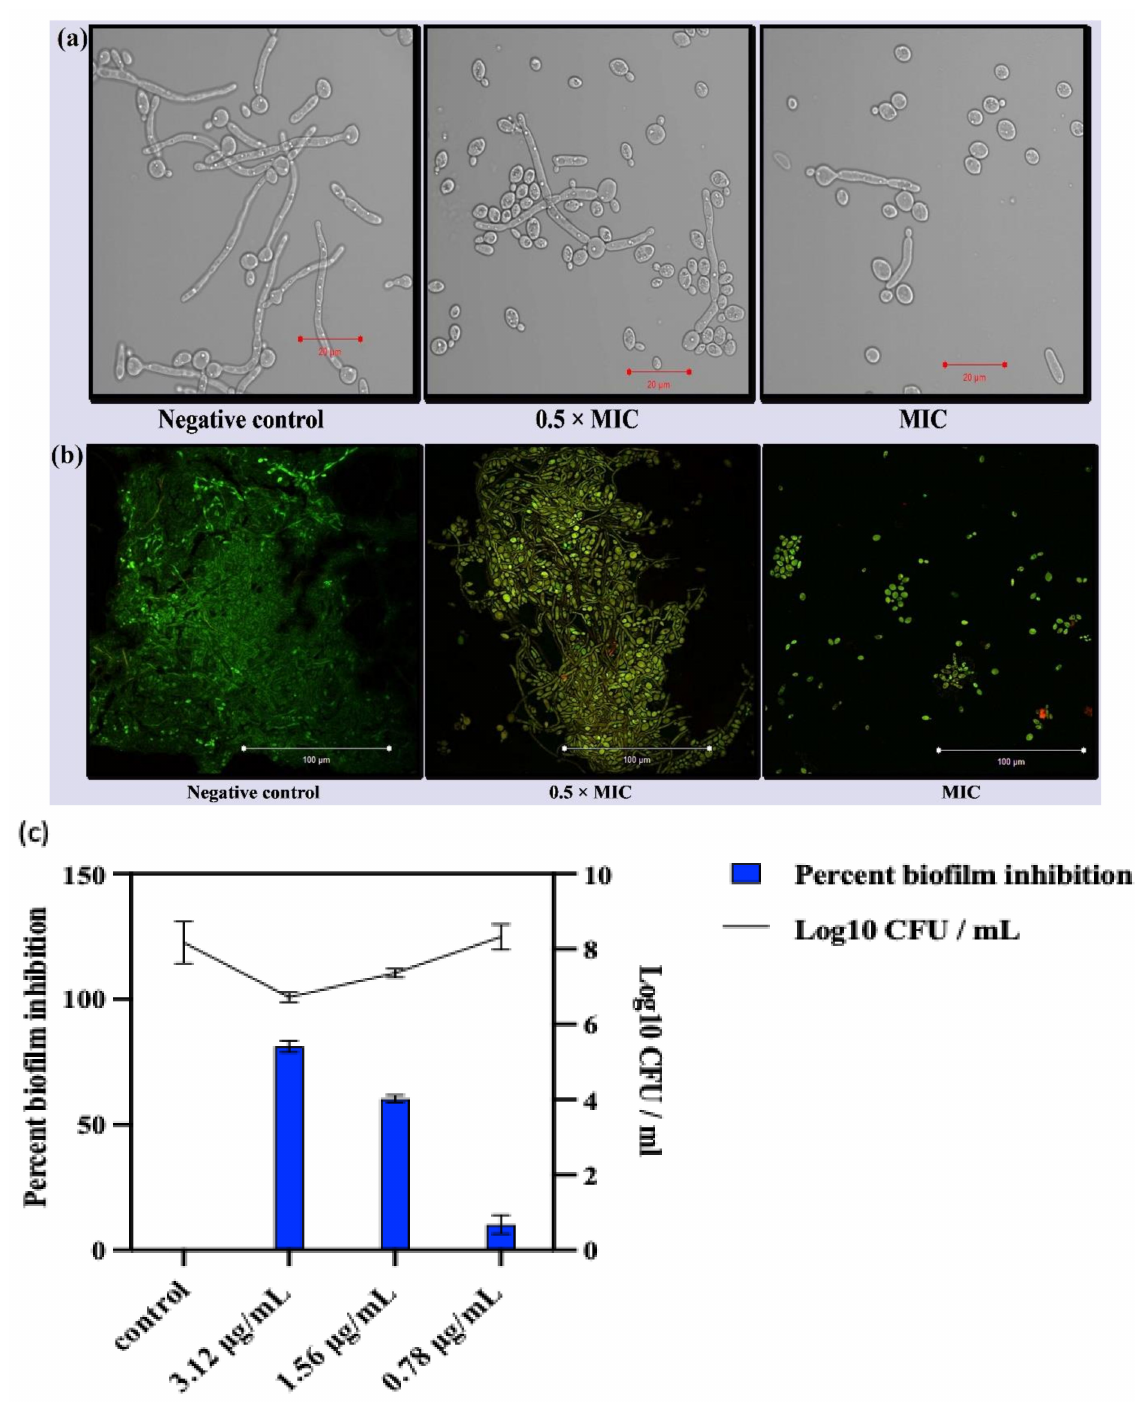
Figure 5. ( a ) Inhibition of morphogenesis in C. albicans 5112. Hyphae formation was monitored at different concentrations of Ag-Ni NPs (0.78 µ g/mL, 0.5 × MIC; 1.56 µ g/mL MIC). Untreated C. albicans 5112 was used as a negative control. ( b ) Anti-biofilm activity of Ag-Ni NPs. The picture shows the effect of Ag-Ni NPs on biofilm formation in C. albicans 5112. The biofilm matrix fluoresces green (Con A), whereas metabolically inactive cells fluoresce yellow-green (FUN-1). ( c ) Percent biofilm inhibition and cell viability within the biofilms with regard to different concentrations of Ag-Ni